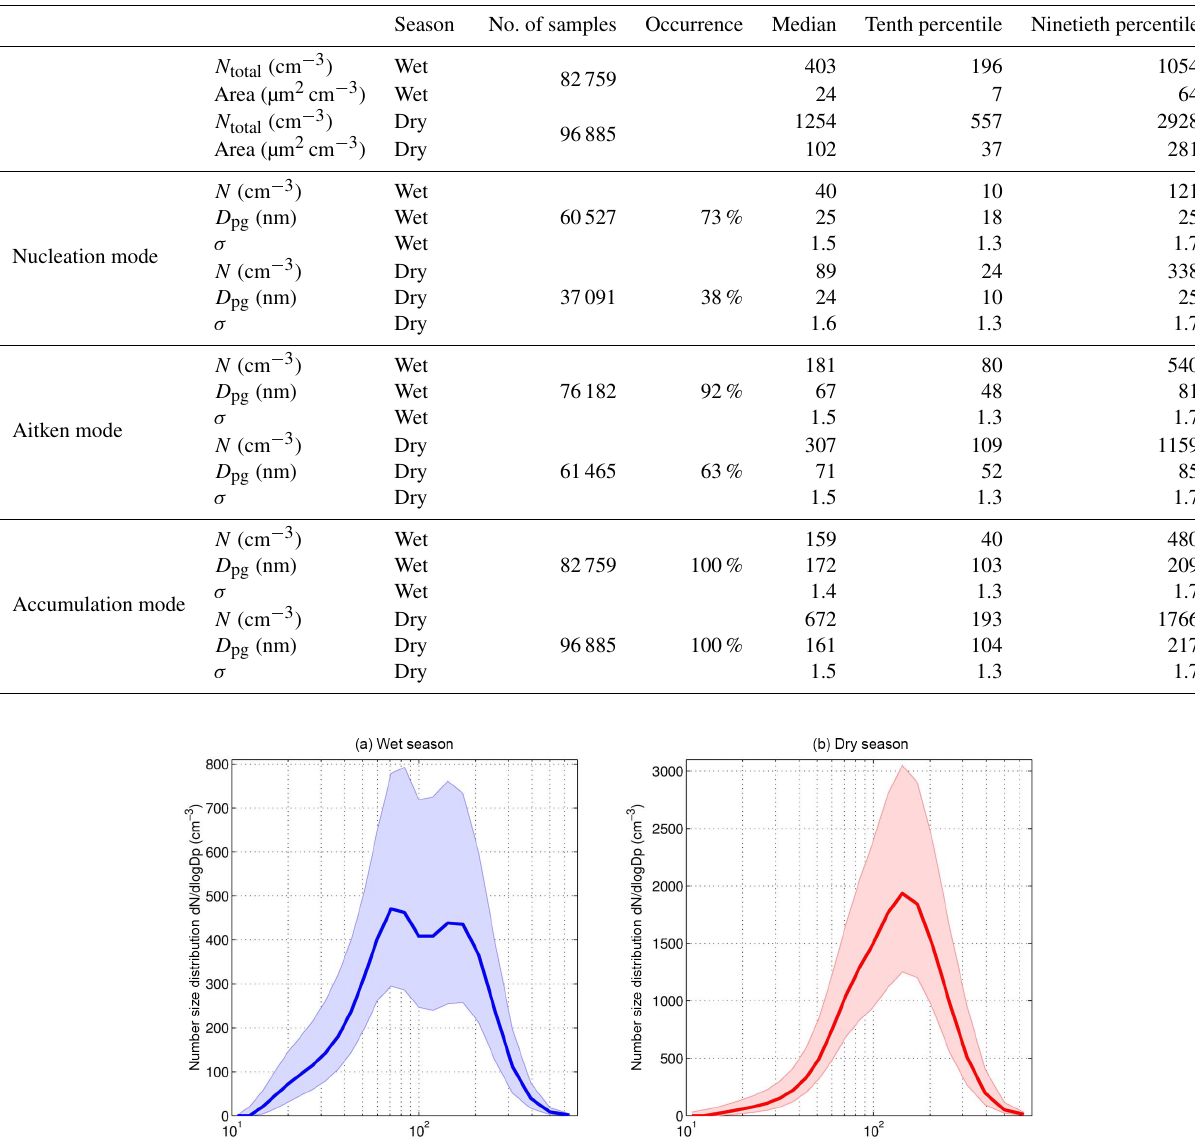
Table 1. Frequency of occurrence, median and 10th and 90th percentiles for particle number size distribution parameters during the wet and dry seasons. Total particle number concentration ( N total ) and surface area were integrated from 10 to 600nm particle size distributions. Particle concentration ( N ), geometric mean diameter ( D pg ) and geometric standard deviation ( σ ) are shown for the lognormal modes fitted to the size distribution samples: nucleation, Aitken and accumulation modes. The wet season period was defined as January–June, and the dry season period was defined as July–December.